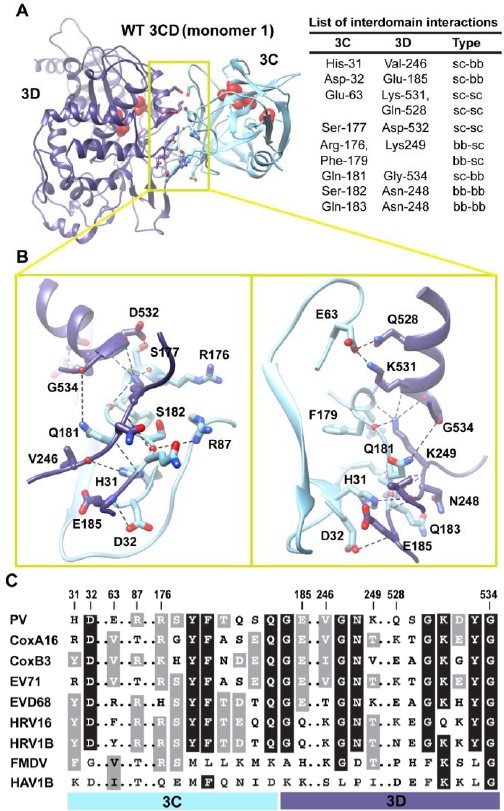
Figure 5. Interactions between 3C and 3D domains in the compact conformation of 3CD (monomer 1). ( A ) Shown is the simulated WT 3CD with interface residues displayed as sticks; the 3C and 3D domains are colored cyan and blue, respectively. The active-site residues of the protease (His-40, Glu- 71, Cys-147) and polymerase (Asp-416, Asp-511, Asp-512) are shown as red spheres to help identifying the relative orientation of the two domains. The list of interdomain interactions is shown at the right of the panel; three types of interactions are indicated (sidechain-sidechain, sc-sc; sidechain- backbone, sc-bb/bb-sc; backbone-backbone, bb-bb). ( B ) Two close-up views of the interface marked by the yellow box in ( A ). Interacting residues are shown as sticks and their C-atoms are colored according to the corresponding domains. Interface residues are engaged in many H-bonding interactions and salt bridges, depicted as black dashed-lines. ( C ) Shown is part of the sequence alignment of 3CD proteins from picornaviruses, including poliovirus (PV), coxsackievirus A16 (CoxA16), coxsackievirus B3 (CoxB3), enterovirus 71 (EV71), enterovirus D68 (EVD68), human rhinovirus 16 (HRV16), human rhinovirus 1B (HRV1B), foot-and-mouth disease virus (FMDV), and hepatitis A virus 1B (HAV1B). The residues shown in the alignment are those involved in the interdomain interactions: 31–32, 63, 87, 176–185, 246–249, and 528–534. Many of the interface residues are highly conserved.